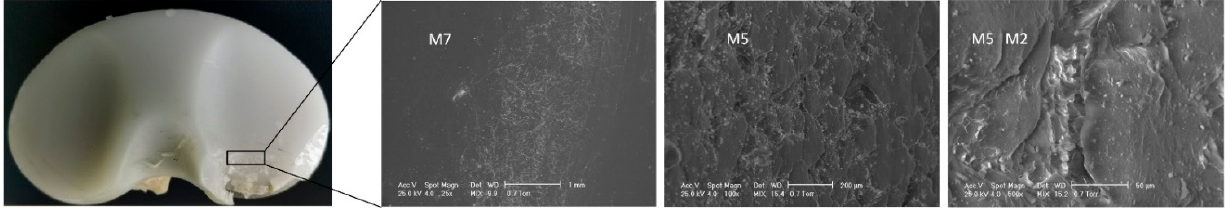
Figure 8. SEM images obtained for IT1 sample.